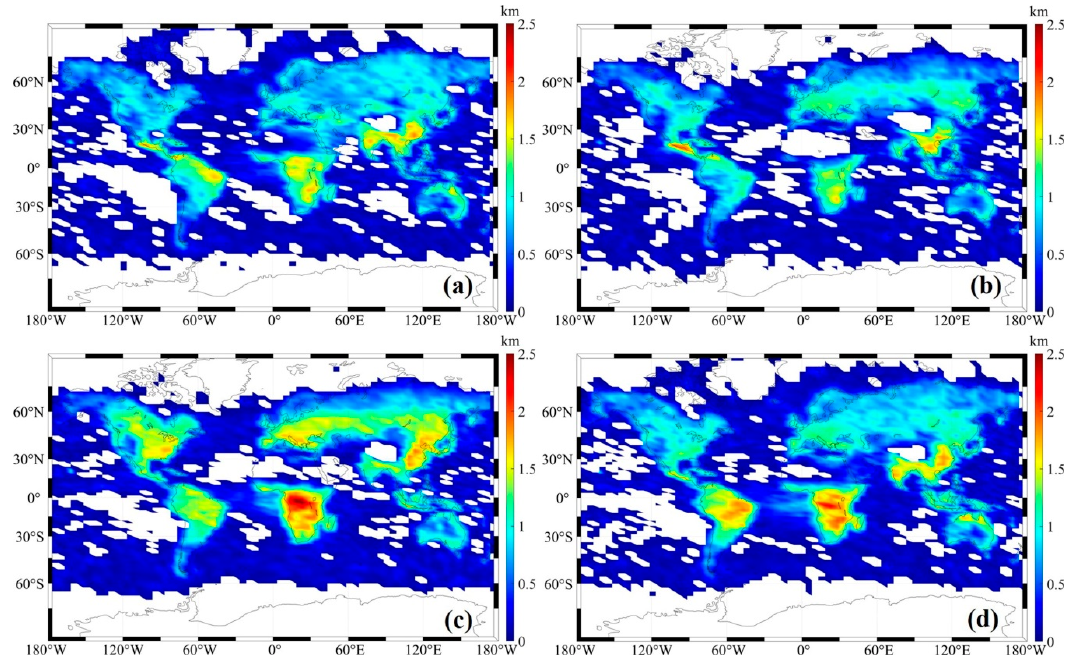
Figure 6. Same as Figure 5 but for the smoke aerosol MFA.